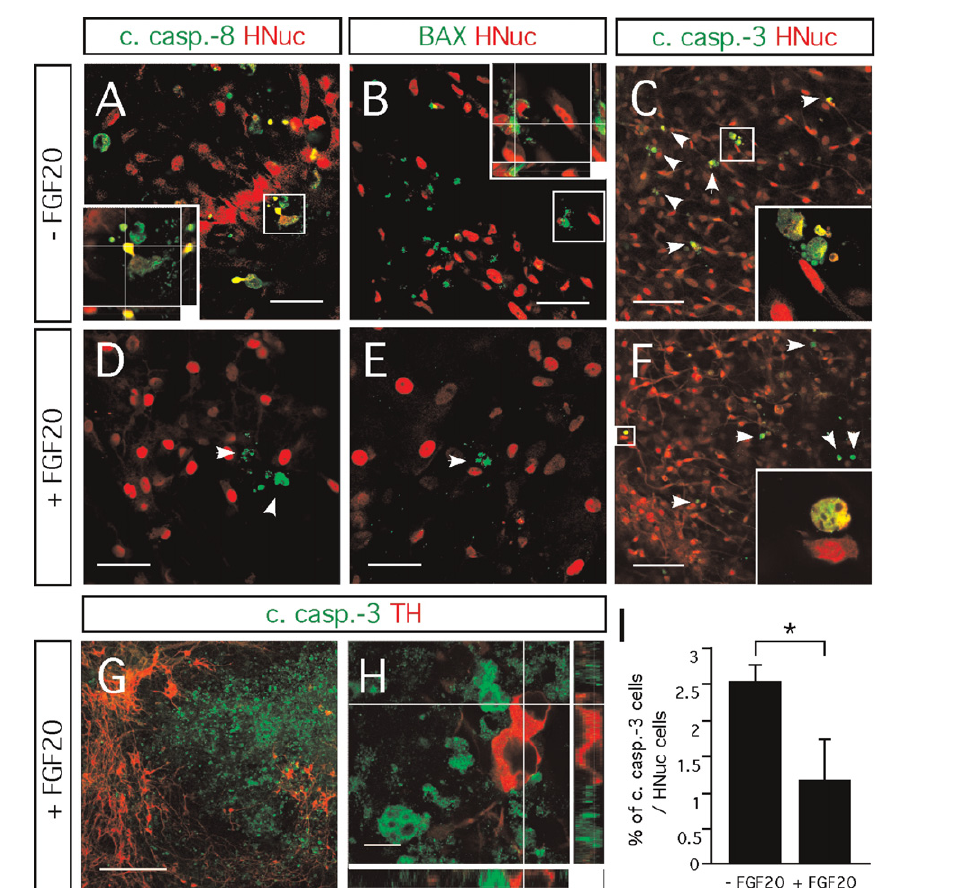
Figure 4. Effect FGF-20 on cell death. Representative images of 3 weeks differentiated hESCs/PA6 co-cultures untreated and treated with FGF-20 ( (cid:2) FGF-20 and þ FGF-20, respectively) double-stained for ( A , D ) HNuc and cleaved caspase-8 ( B , E ), HNuc and BAX ( C , F ) HNuc and cleaved caspase-3 (arrowheads point on apoptotic cells), and ( G , H ) TH and cleaved caspase-3. ( I ) Graphic representation of the percentages of cleaved caspase-3-positive cells among HNuc-positive cells in 3 weeks differentiated hESCs/PA6 co-cultures (cid:2) FGF-20 and þ FGF-20. Average (cid:1) SEM. Student’s t-test, p-value: * ¼ 0.05. (G, H) Images showing cells positive for cleaved caspase-3 and TH in 3 weeks differentiated hESCs/PA6 co-cultures þ FGF-20. Distance bars: A, B, D, E: 50 m m; C, F: 100 m m; G: 200 m m; H: 10 m